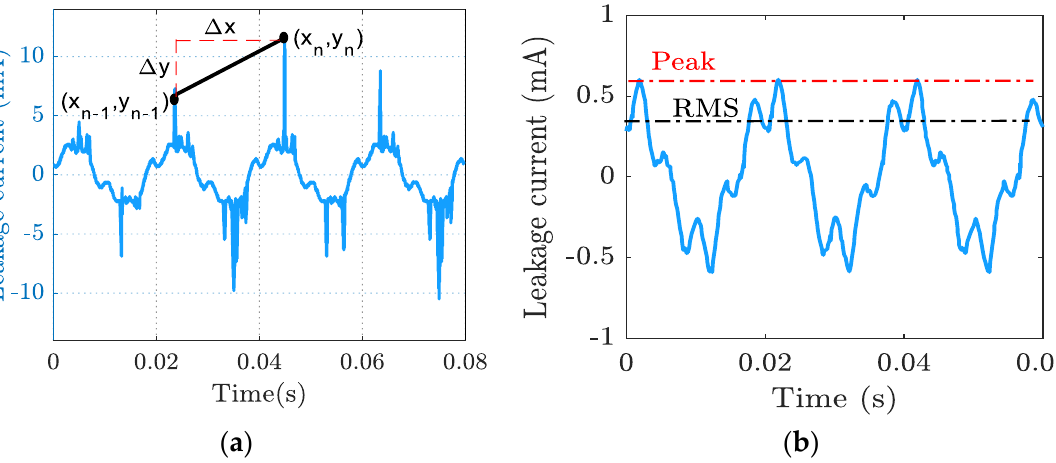
Figure 4. ( a ) Slope curve extracted from leakage current waveform; ( b ) crest factor indicator extracted from leakage current waveform.